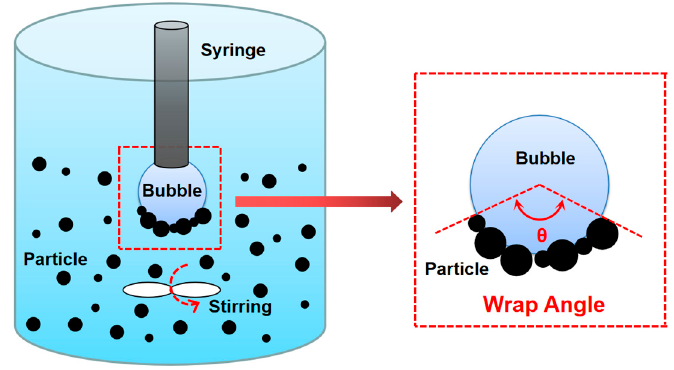
Figure 3. Schematic of bubble–particle wrap angle Figure 3 . Schematic of bubble–particle wrap angle experiment.